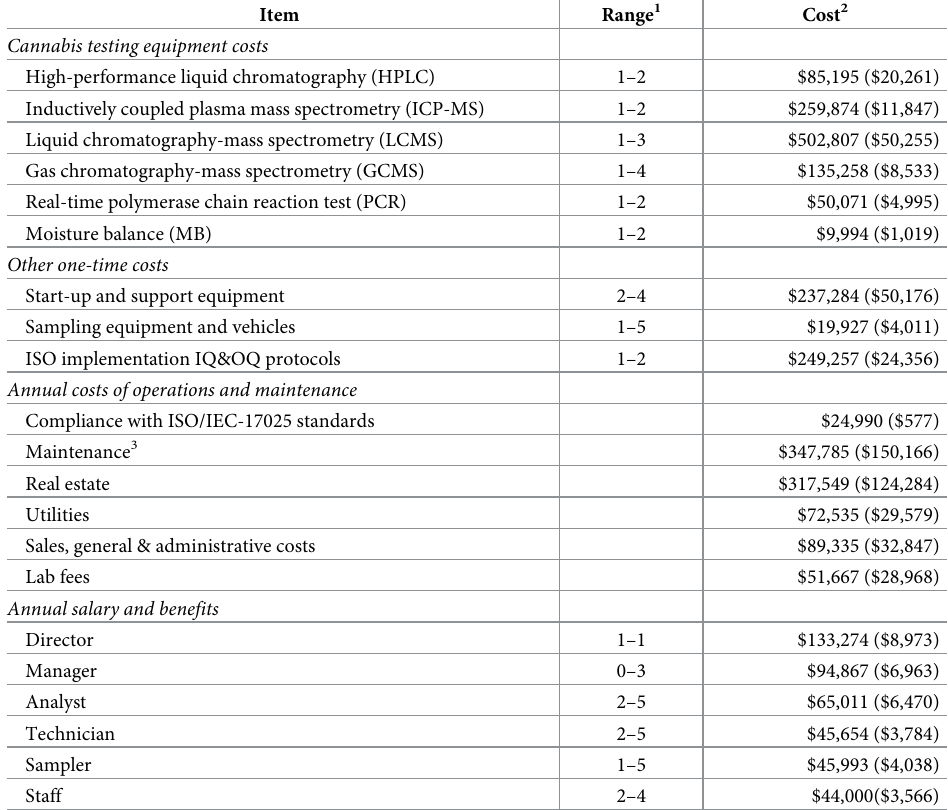
Table 3. Average expected costs of implementing a licensed cannabis testing laboratory in